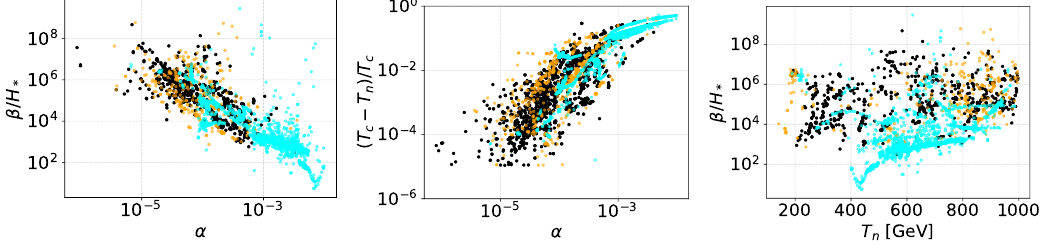
Figure 9 . The gray points in both panels show all scanned points while the orange (black) points show the points leading to a (cid:12)rst-order phase transition but are excluded (allowed) by XENON1T constraints on the direct-detection cross section. The cyan points are the ones generated by the re(cid:12)ned scan.